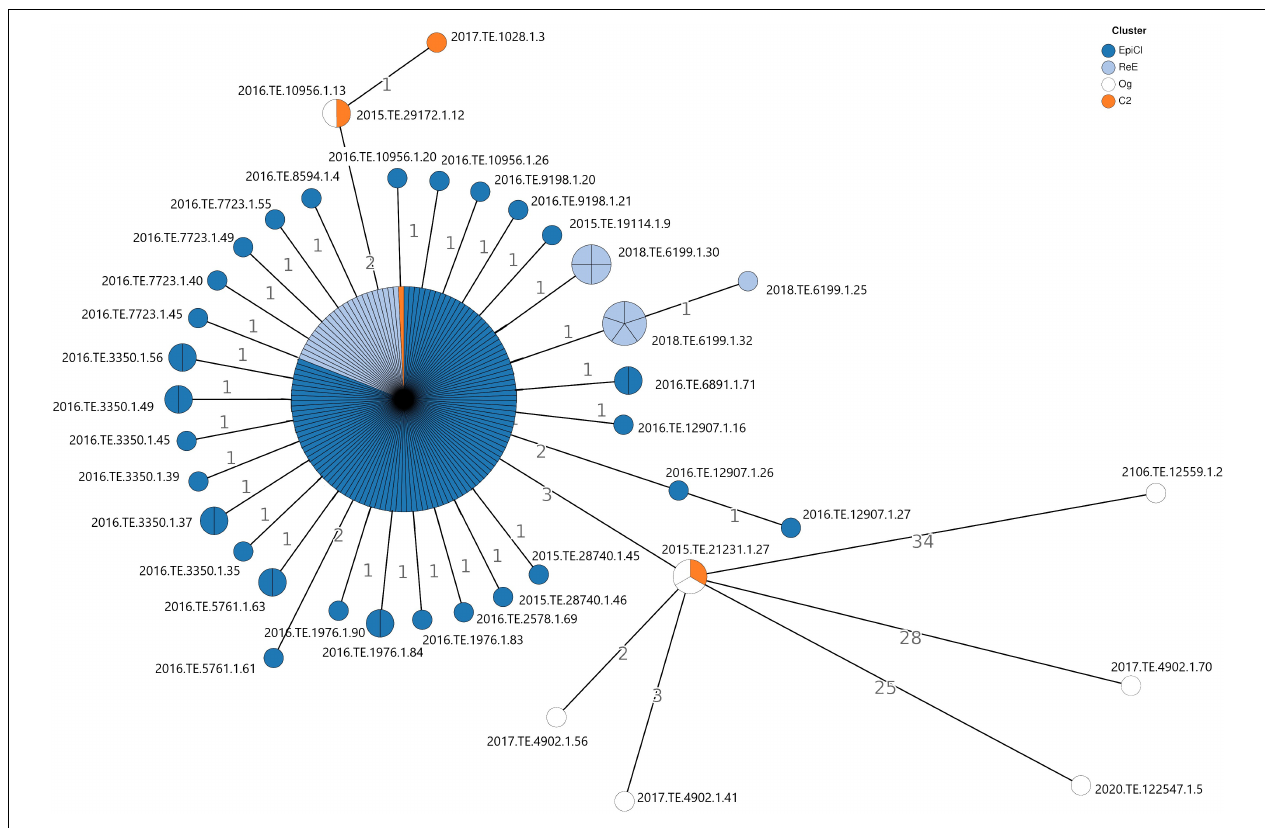
FIGURE 1 | Cluster analysis based on gene-by-gene results of the 186 L. monocytogenes isolates tested in this study. The nodes are colored according to the cluster (Epidemic, Cluster2, and Re-emergence Cluster). The number reported in the branches indicate the allelic differences existing between the isolates.